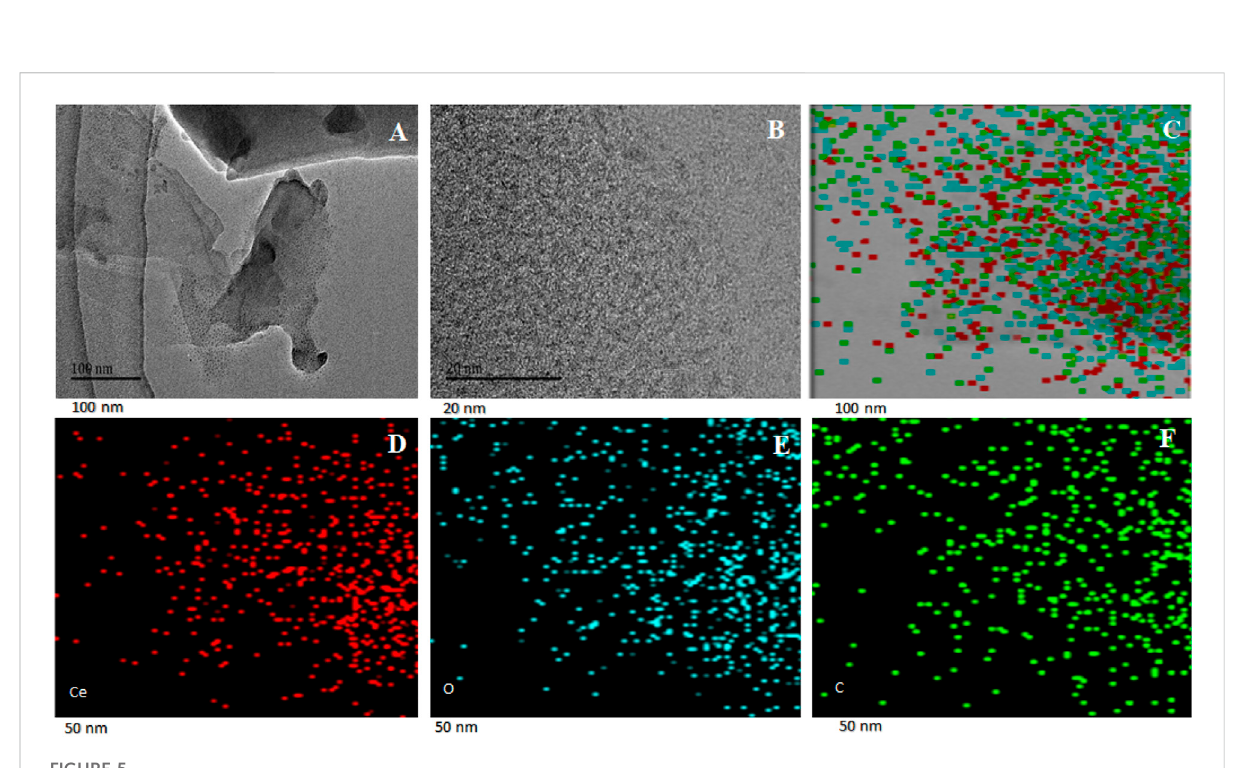
FIGURE 5 HRTEM images of GO@Ce-MOF composite (A,B) and EDS elemental mapping (C – F)